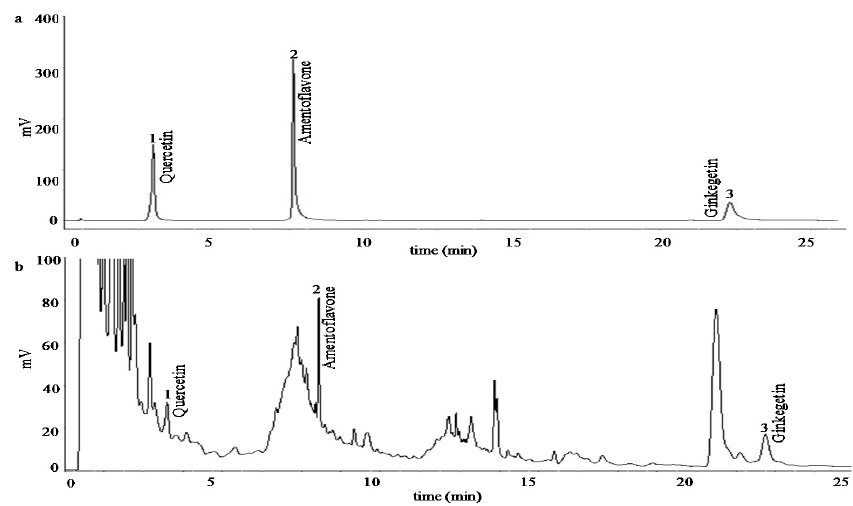
Figure 7. UPLC chromatogram of the three flavonoids. ( a ): standard chromatogram; and ( b ): samples chromatogram. Chromatogram conditions were given in Section 3.4.2.